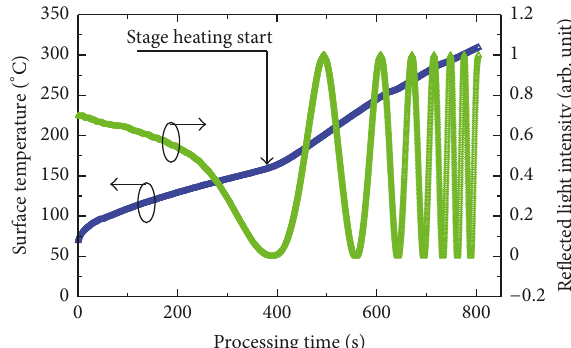
Figure 1: The reflected light intensity and the surface temperature as a function of processing time. The photoresist film was only prebaked at 100 ∘ C for 60s. The catalyst temperature was 1600 ∘